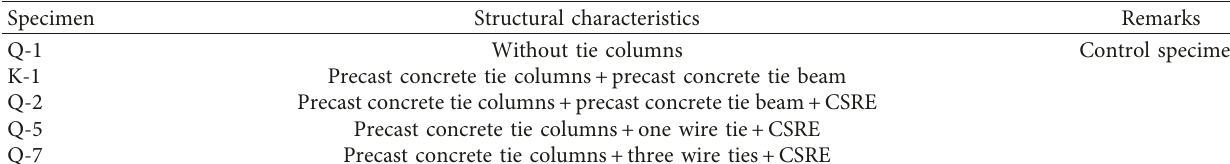
Table 3: Summary of structural characteristics of the tested specimens.